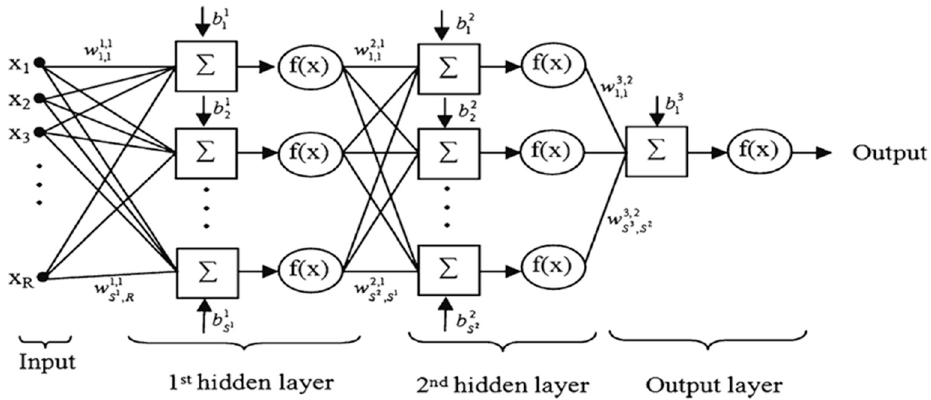
Figure 4. An example of a feed-forward MLP network with two hidden layers. Xs, Ws, bs, and f(x) are inputs, weights, biases, and activation function, respectively.